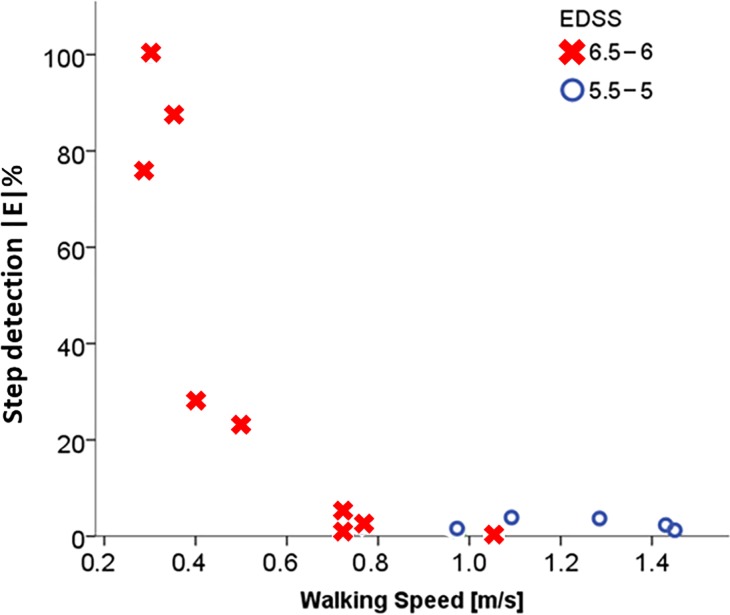
Relationship between mean percentage error for step detection (|E|%) of the algorithm W-PAM and walking speed according to disability group (EDSS score).All the participants with disability levels of 5.0 or 5.5 show very low errors and walking speeds above 0.8 m/s. For participants with disability levels of 6.0 or 6.5 the errors increase, particularly at the slowest walking speeds.